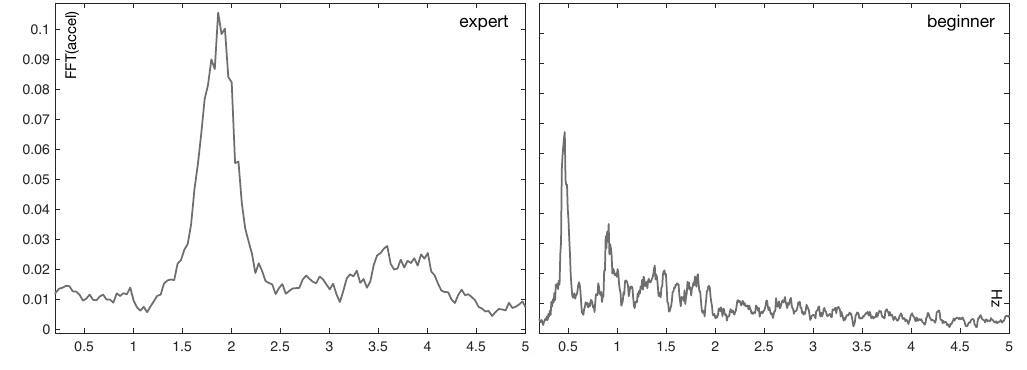
Figure 3. Examples of the accelerometer data of two aikido practitioners with different levels performig the shikko movement. The plots show the computed two-sided spectrum of the